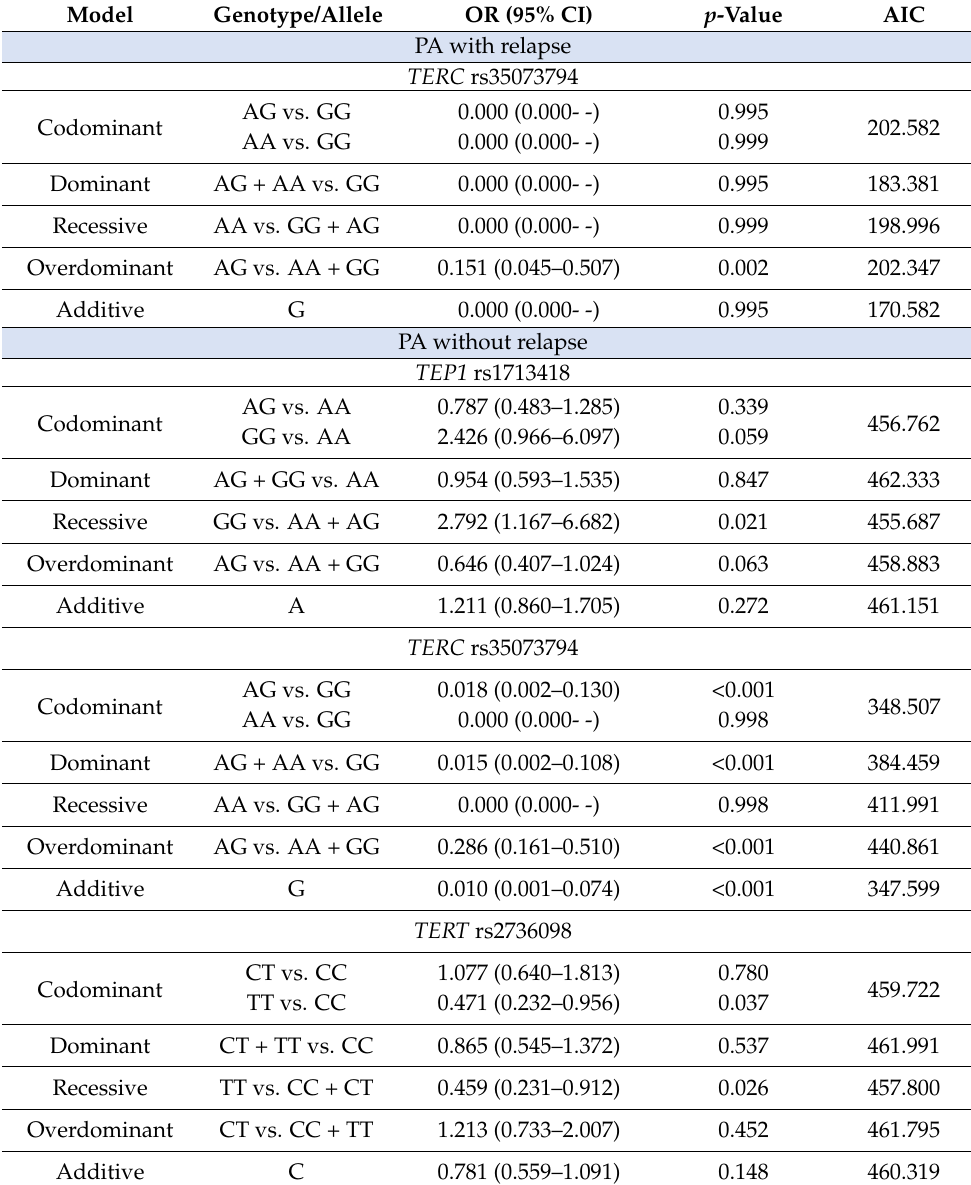
Table 9. Binary logistic regression analysis within PA with or without relapse and control group